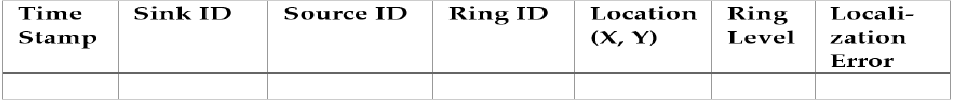
Figure 4. Frame format of the SPI (sink position information) for the ring node.